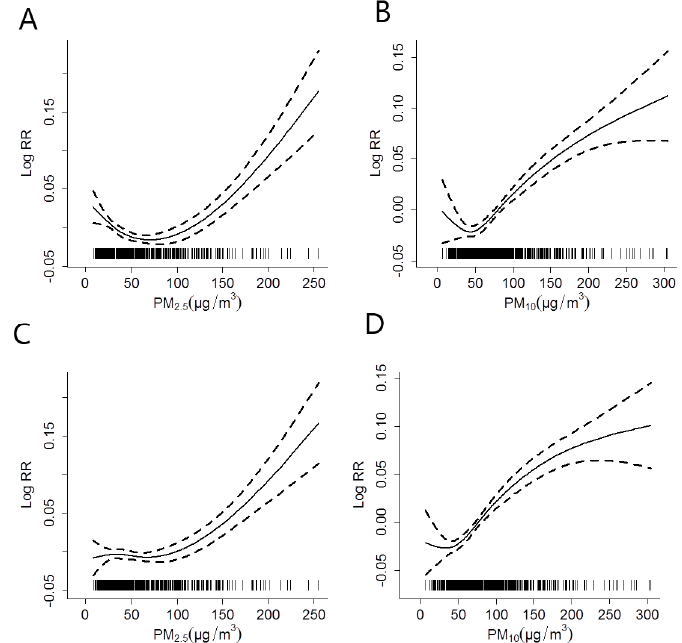
Figure 3. The concentration-response relationships for PM 2.5 and PM 10 with IHD hospitalizations at lag 0 across all seasons, after adjusting for the effect of OZONE ( C , D ) or without adjustment ( A , B ). The X-axis represents the PM concentrations ( μ g/m 3 ) on the concurrent day. The Y-axis represents the log-relative risk on the IHD hospitalizations. The solid line indicates the estimated mean change in the log-relative risk, while the dotted lines represent the 95% CI of the estimates.